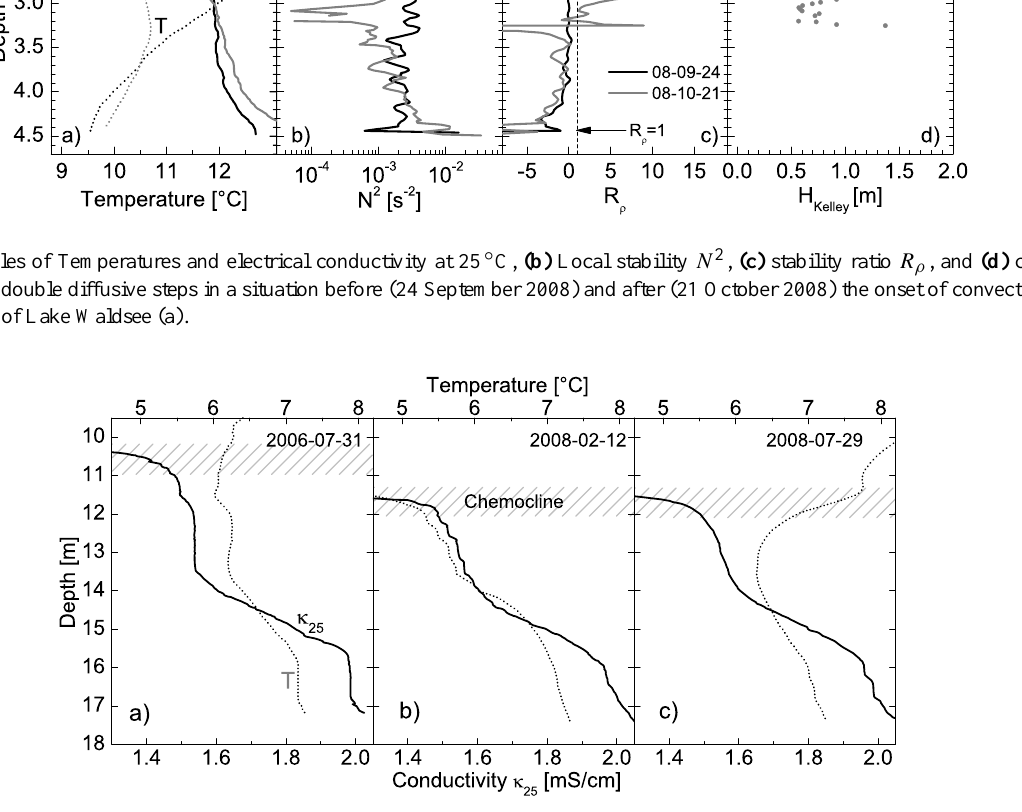
Fig. 5. CTD - profiles at Lake Moritzteich from two different years documenting variable shaping of double diffusive mixing (formation of steps): (a) (2006) two steps in the upper part of the monimolimnion, one step near the bottom, (b) (2008, winter) several steps in the upper part, no clear structure near the bottom, (c) (2008, summer) steps in the upper part disappeared, step formation near the